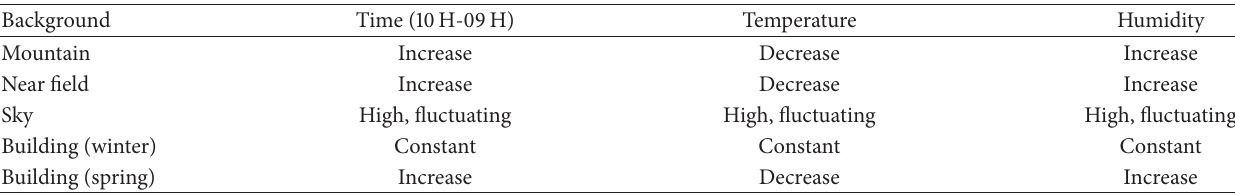
Figure 10: SCR computation flow: (a) registered raw input data (14bits), (b) SNR enhanced input image, (c) background estimation result, (d) contrast result, (e) standard deviation estimation, and (f) computed SCR map. Table 4: Summary of the SCR variations according to the time, temperature, and humidity for various backgrounds.